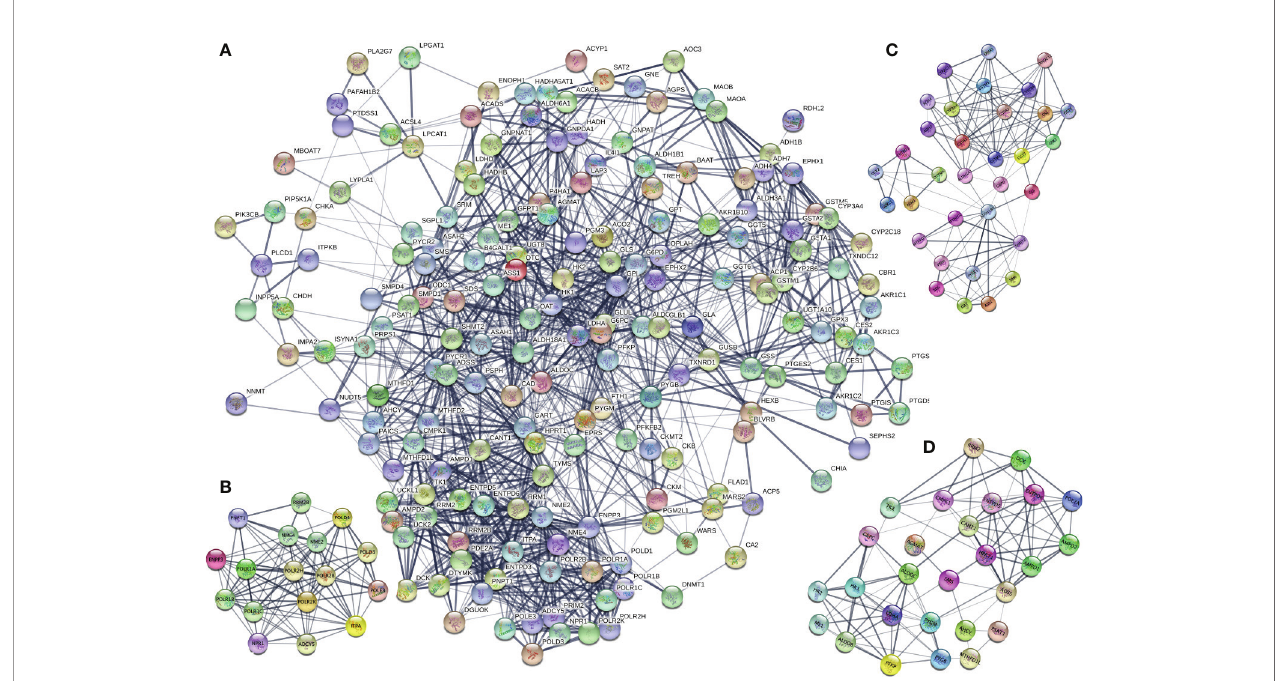
FIGURE 3 | Protein-protein interaction (PPI) network of the differentially expressed metabolism-related genes (DEMRGs) in stomach adenocarcinoma (SATD). (A) PPI network of the DEMRGs in SATD. (B – D) The entire PPI network was analyzed using MCODE, and three modules (module 1 score=12.375, module 2 score=8, and module 3 score=7. 615) were